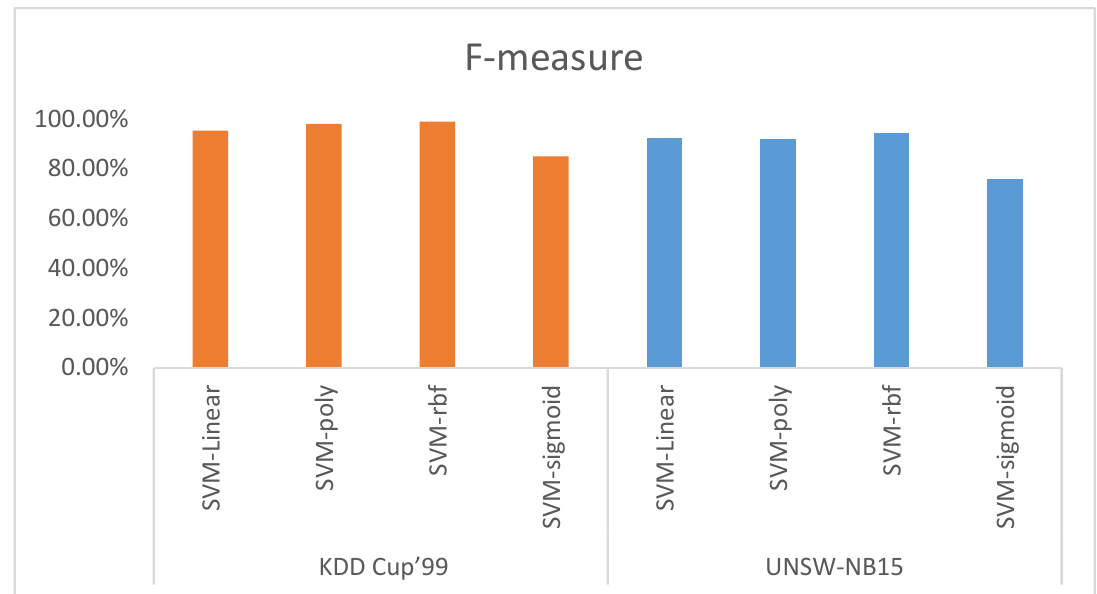
Figure 10. F-Measure. Figure 10.